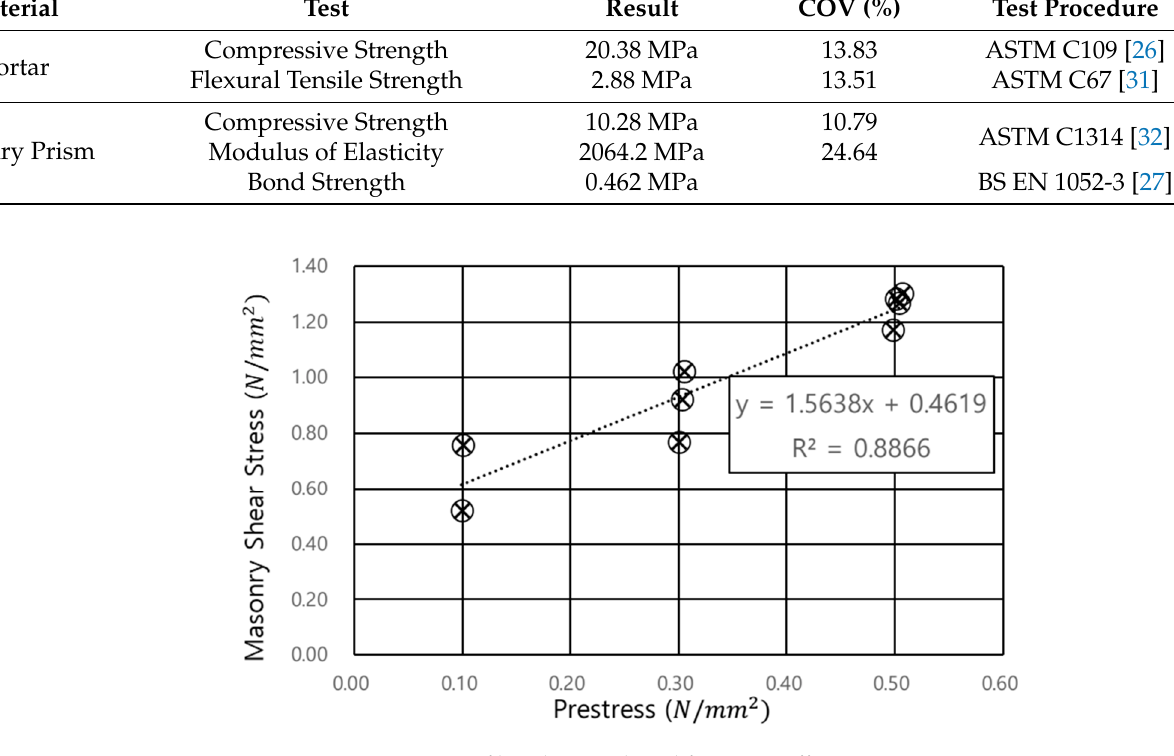
Figure 4. Determination of bond strength and friction coefficient.